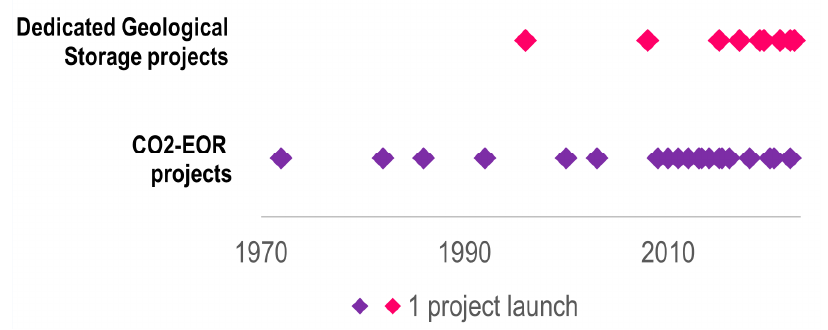
Figure 8. Distribution of the operational CCS projects in time by type based on